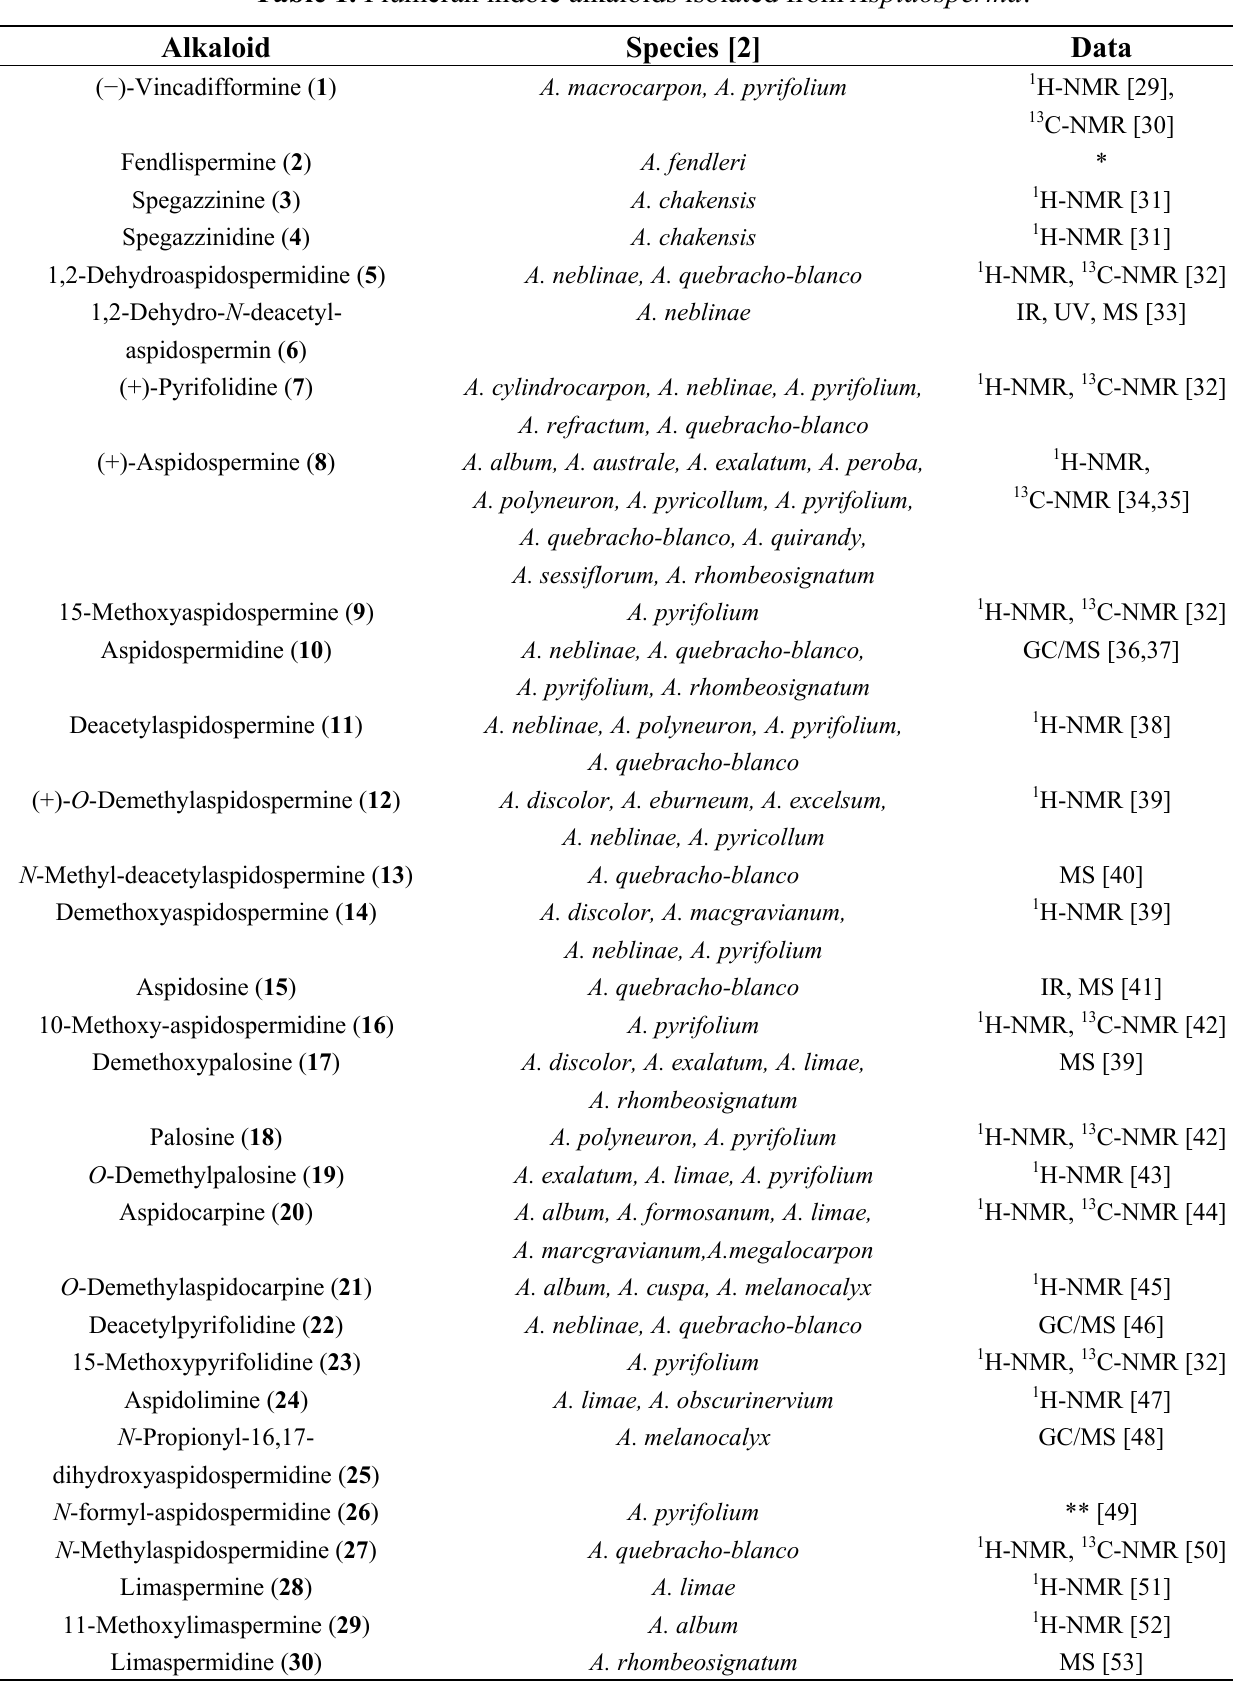
Table 1. Plumeran indole alkaloids isolated from Aspidosperma . Alkaloid Species [2]